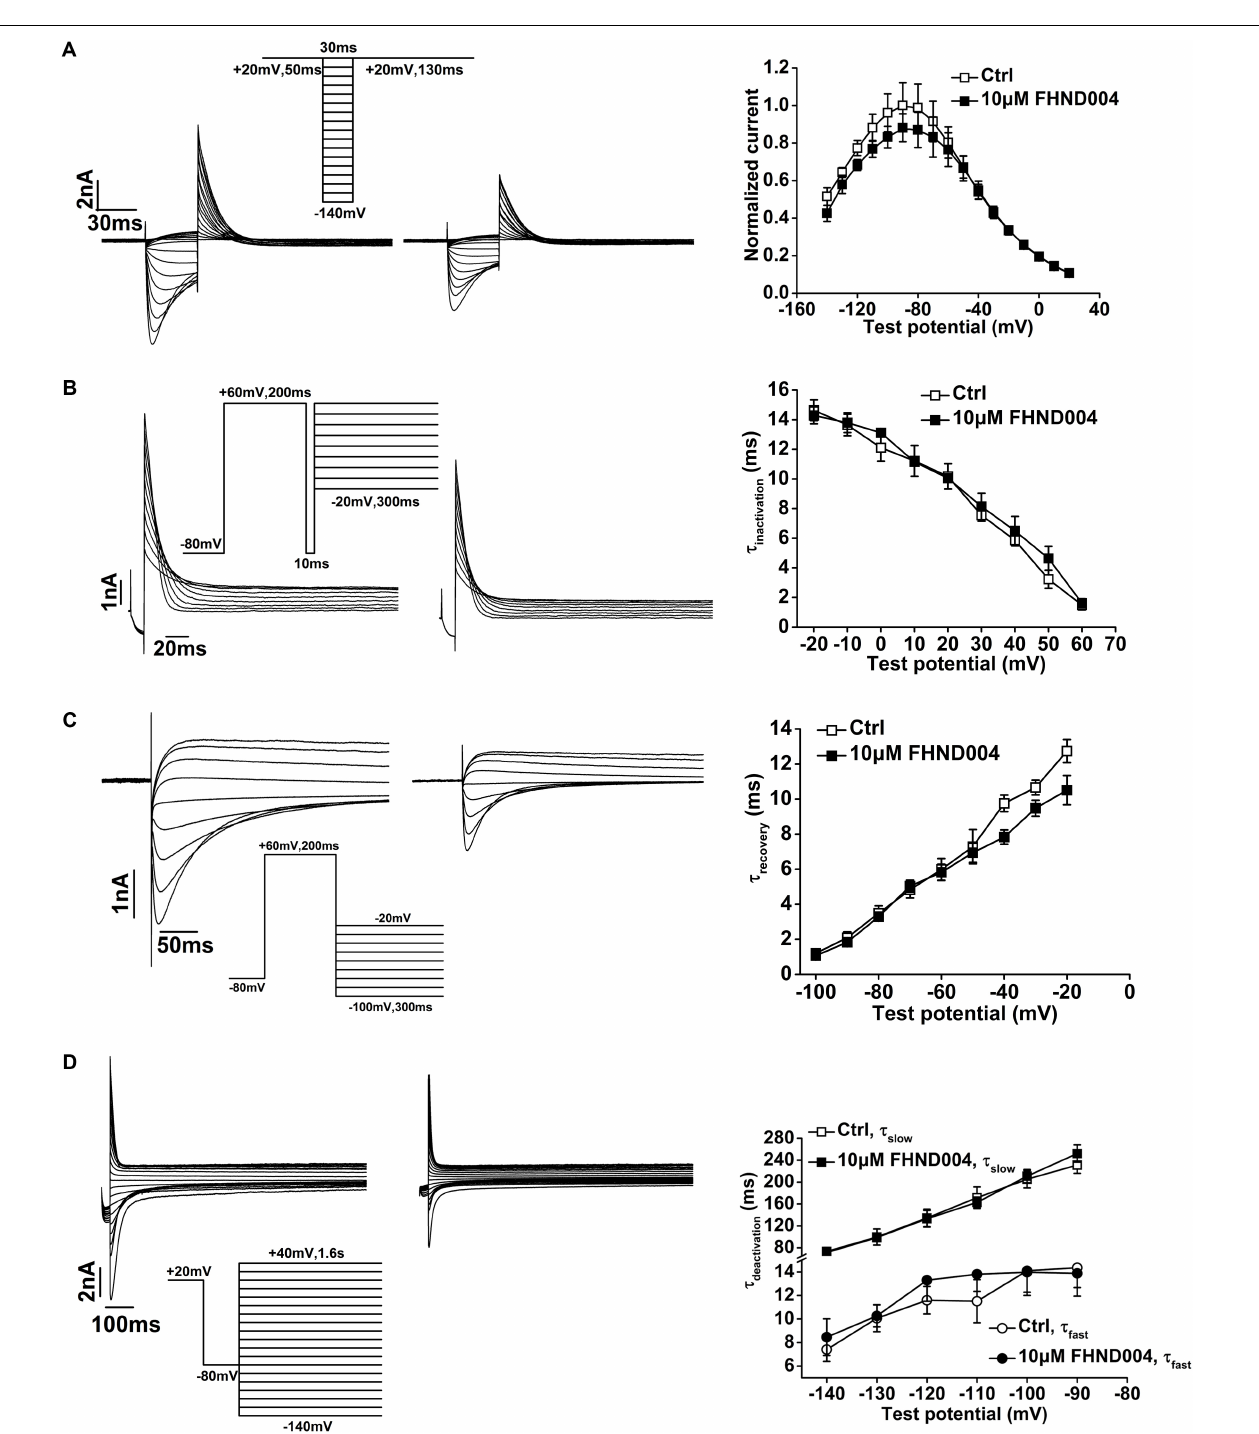
FIGURE 4 | Effects of FHND004 on hERG channel kinetics. (A) Representative current traces of steady-state inactivation before and after the application of 10 µ M FHND004 (left) with the protocol shown in the inset and I – V relationships of the outward inactivation current elicited during the second step to +20 mV obtained in the absence and presence of 10 µ M FHND004 (right, n = 6). (B) Representative current traces of the time-course of hERG inactivation recorded by a three-pulse protocol before and after the application of 10 µ M FHND004 (left) and inactivation time constant (tau) fitted by a single exponential equation (right, n = 5). (C) Representative current traces of recovery from inactivation before and after application of 10 µ M FHND004 (left) and the time constant (tau) of recovery from the inactivation fitted by a single exponential equation (right, n = 6). (D) Representative current traces of deactivation before and after the application of 10 µ M FHND004 (left) and the fast and slow time constants (tau) fitted by a double exponential equation (right, n = 7).